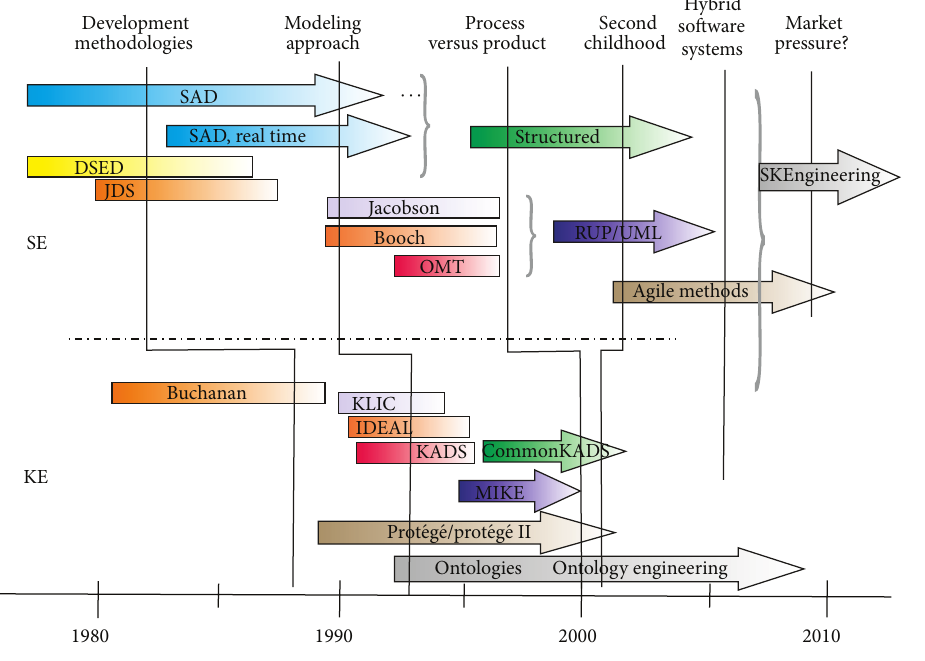
Figure 1: Methodologies evolution and